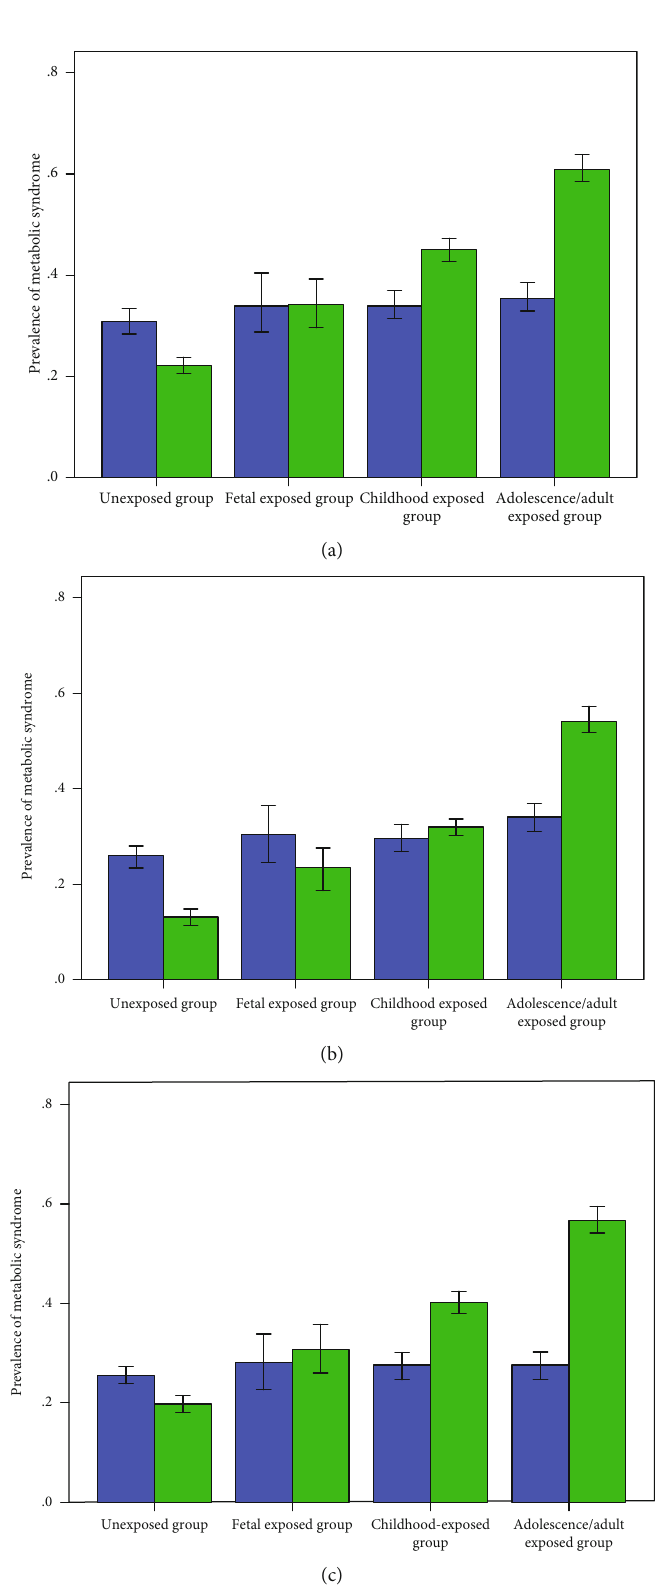
Figure 1: Sex-speci fi c prevalence (95% con fi dence interval) of metabolic syndrome in di ff erent life stages exposed to the 1959-1961 Chinese Famine, according to the NCEP-ATP III (a), CDS (b), IDF (c) diagnosed criteria. The blue bar indicates men and green bar for